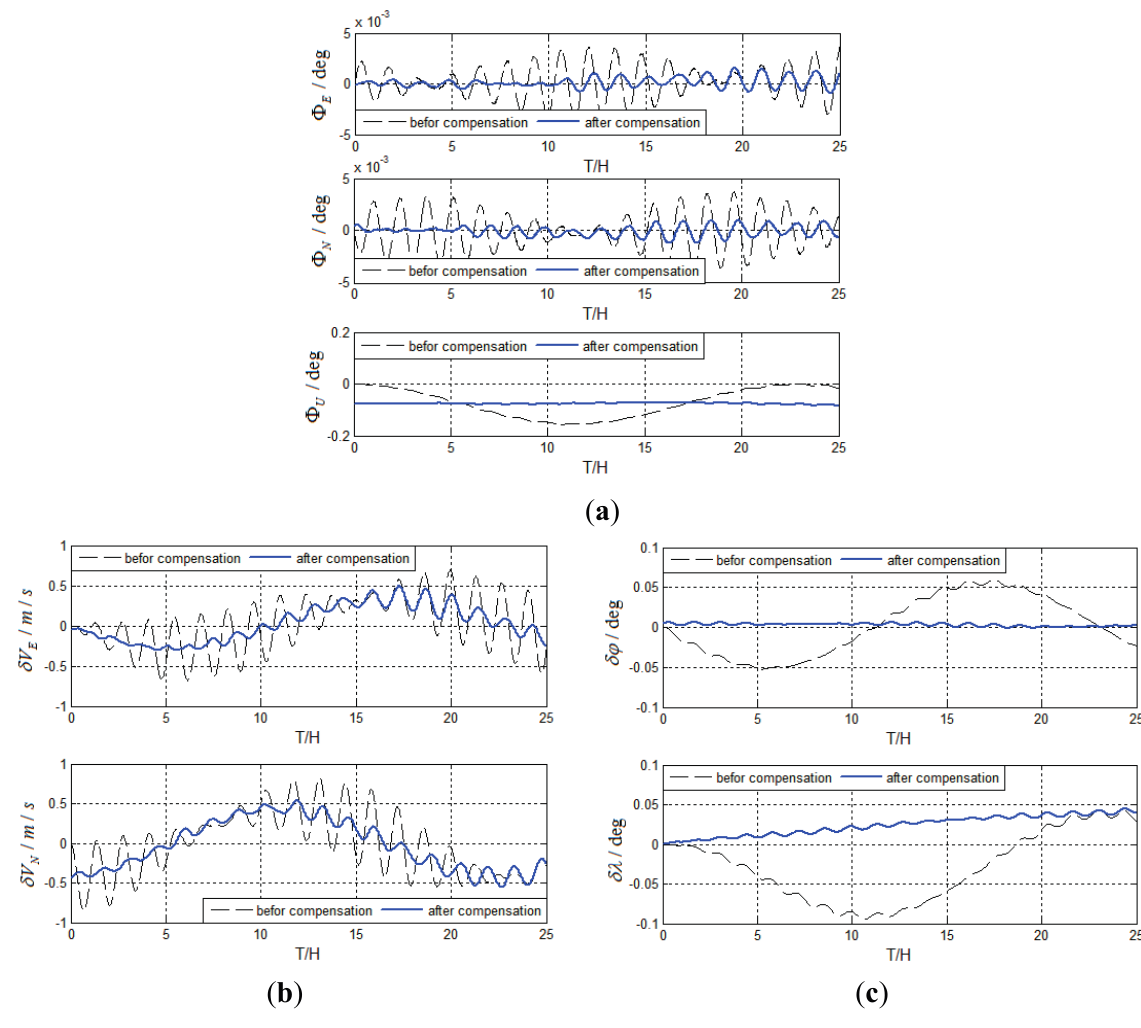
Figure 12. ( a ) Test results of attitude errors for actual system; ( b ) Test results of velocity errors for actual system; ( c ) Test results of position errors for actual